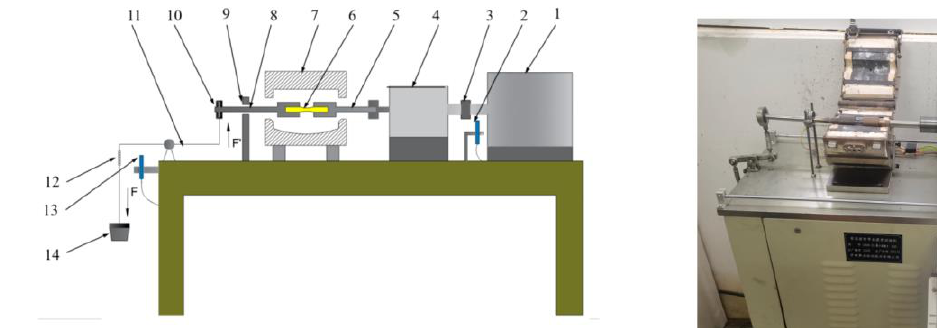
Figure 5. High-temperature rotating bending fatigue machine. ( a ) Schematic diagram and struc- tural compositions of high-temperature rotating bending fatigue machine; ( b ) high-temperature rotary bending fatigue testing machine physical picture.